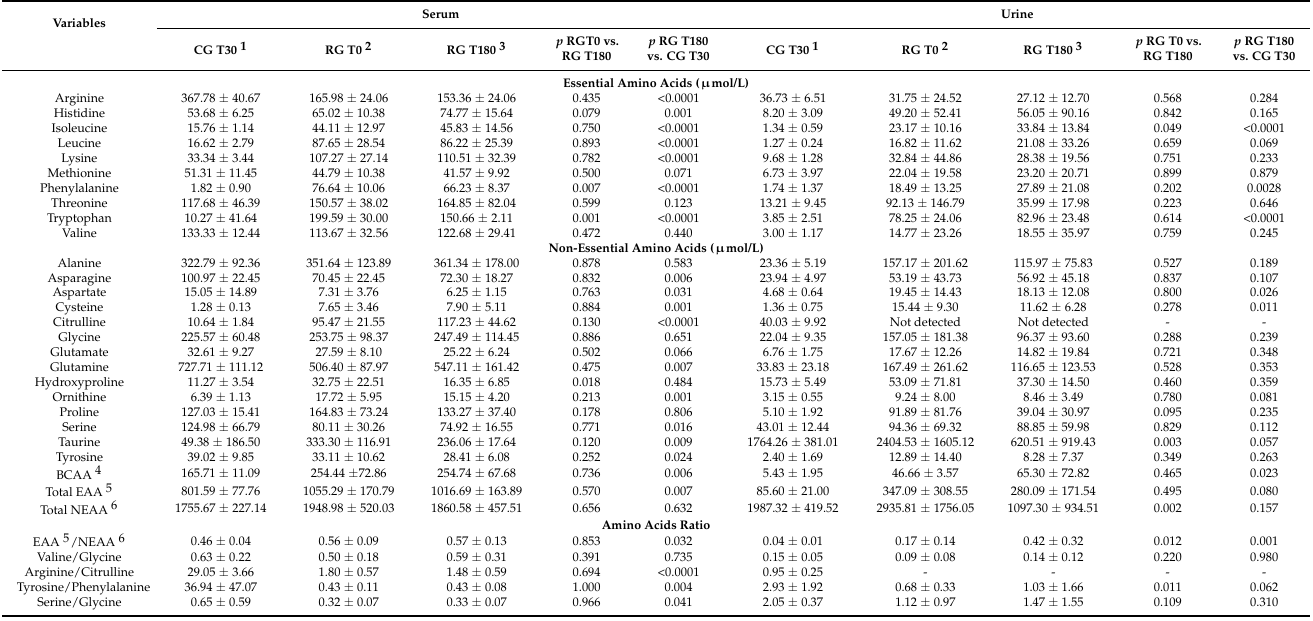
Table 3. Mean concentrations ± SD of serum and urinary amino acids in healthy dogs and dogs with chronic kidney disease stages 3 and 4 fed with a renal diet.